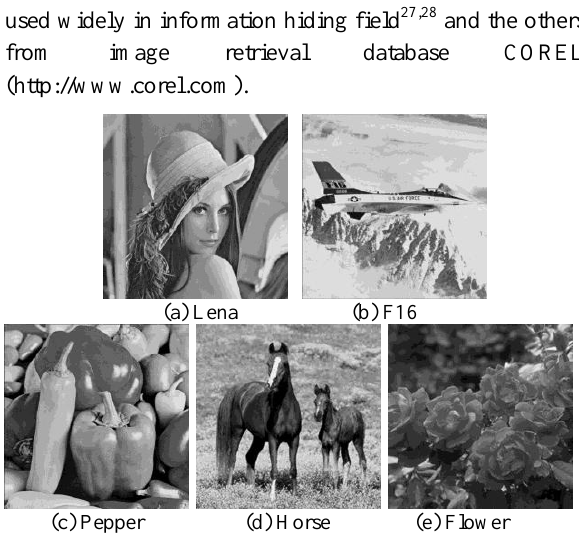
Fig. 5. The five cover